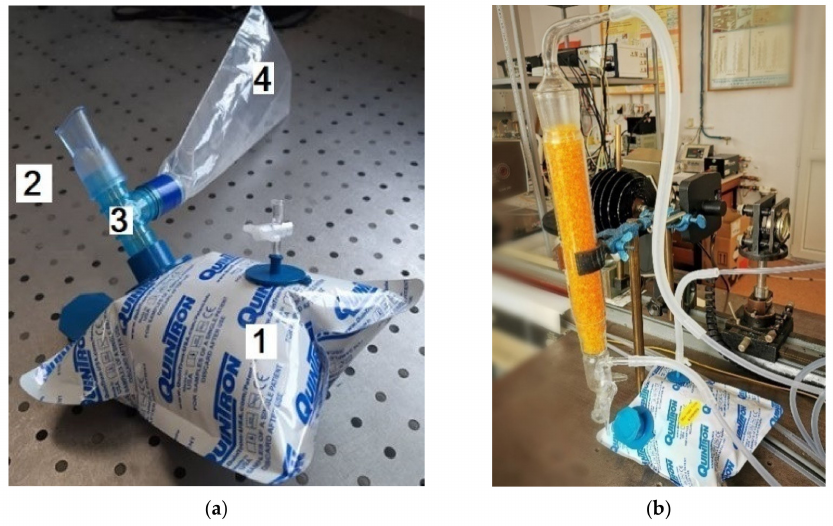
Figure 2. ( a ): 1—0.75 L Aluminium-coated bags (QuinTron, USA); 2—Mouthpiece; 3—Tee connector; 4—0.40 L Discard bag;( b ) Connected SiO 2 trap and aluminum-coated